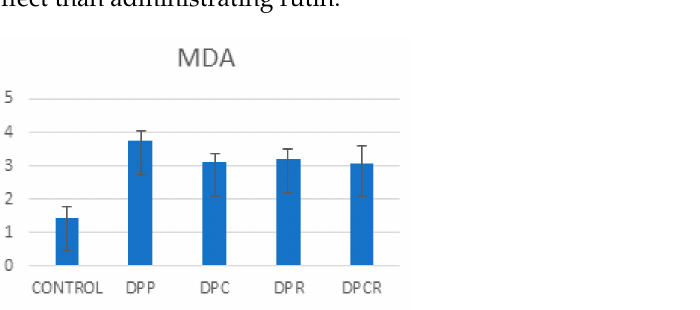
Figure 1. Mean variable evolution of malondialdehyde (MDA). DPP—placebo group; DPC— curcumin alone; DPR—rutin; DPCR—curcumin and rutin.